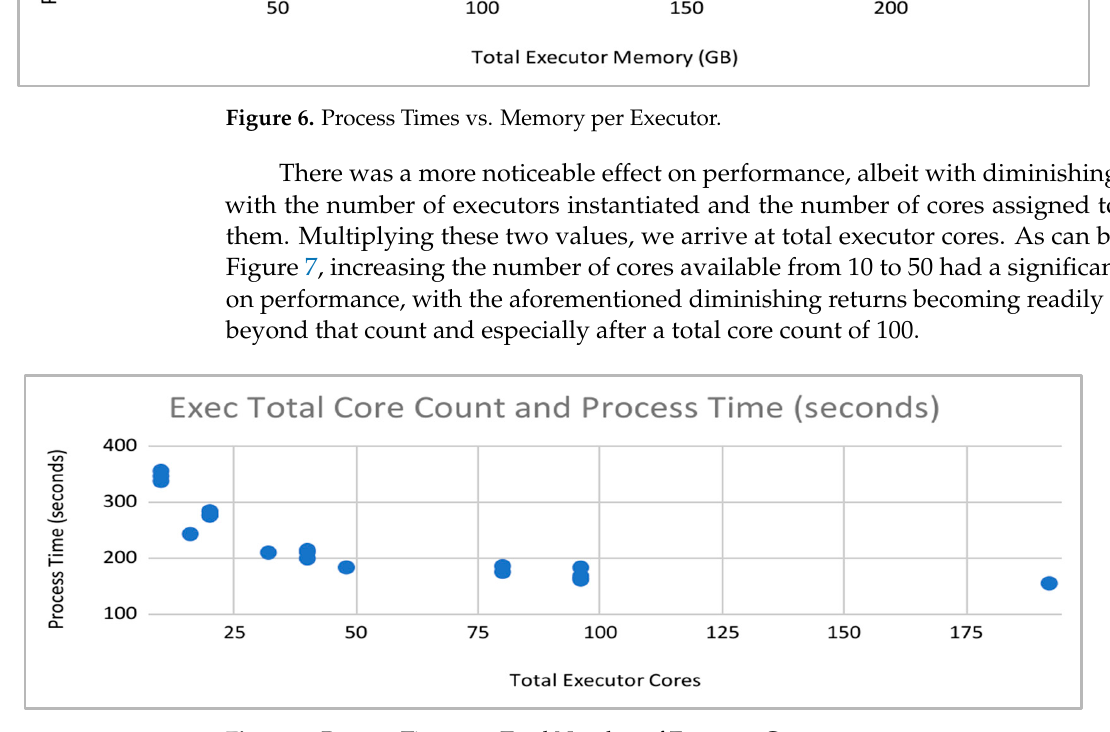
Figure 7. Process Times vs. Total Number of Executor Cores.